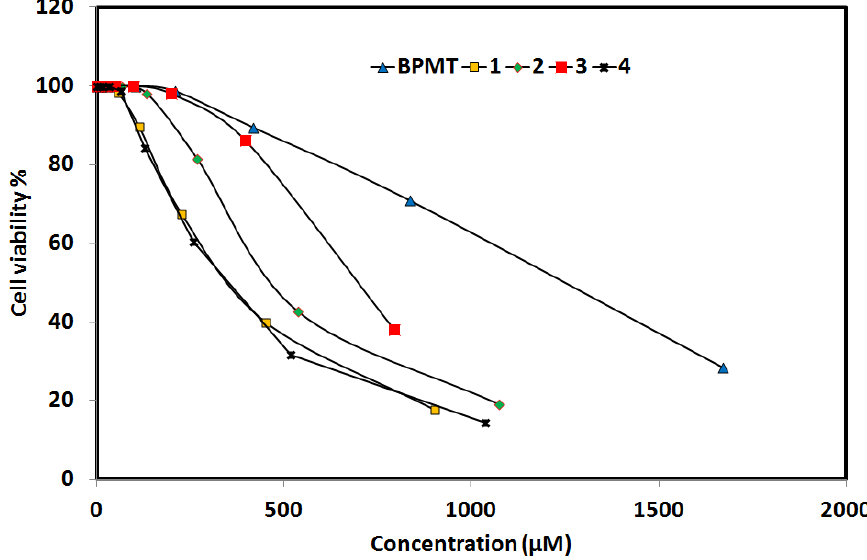
Figure 6. The cytotoxic activity of the studied compounds against A-549 cell